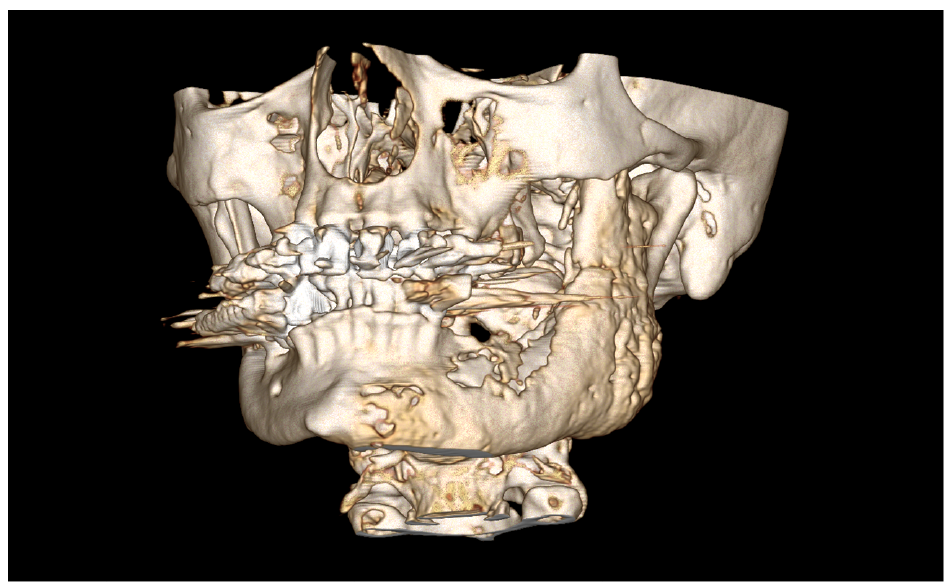
Figure 9. CT reconstruction of the midface and mandible shows a massive periost reaction due to MRONJ of the mandible.